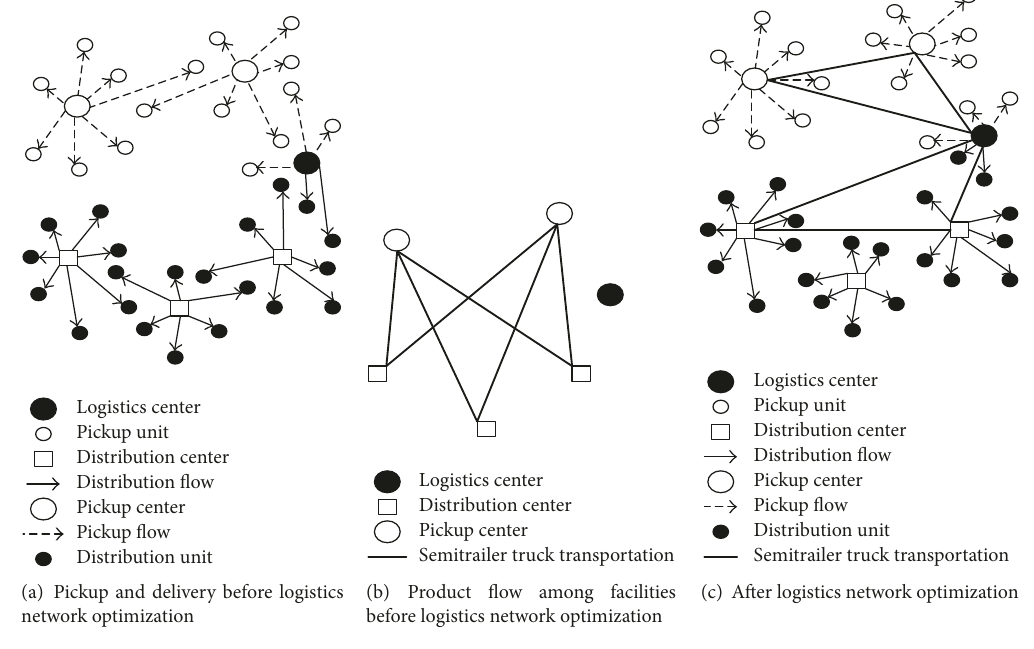
Figure 1: Logistics network